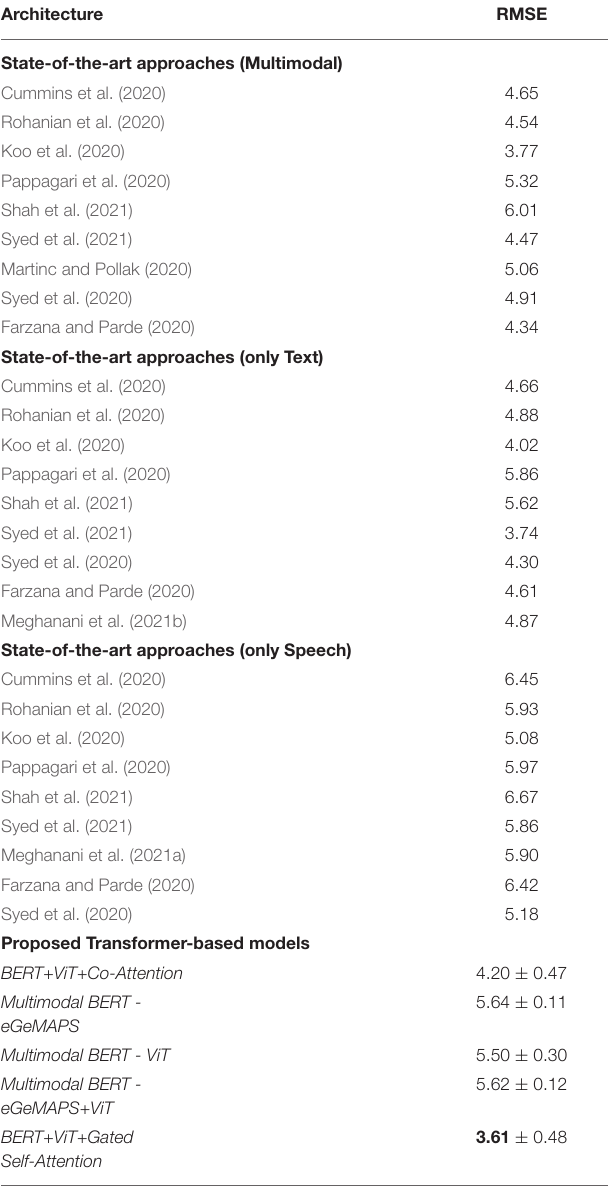
TABLE 5 | MMSE Regression Task: performance comparison among proposed models and state-of-the-art approaches on the ADReSS Challenge test set.